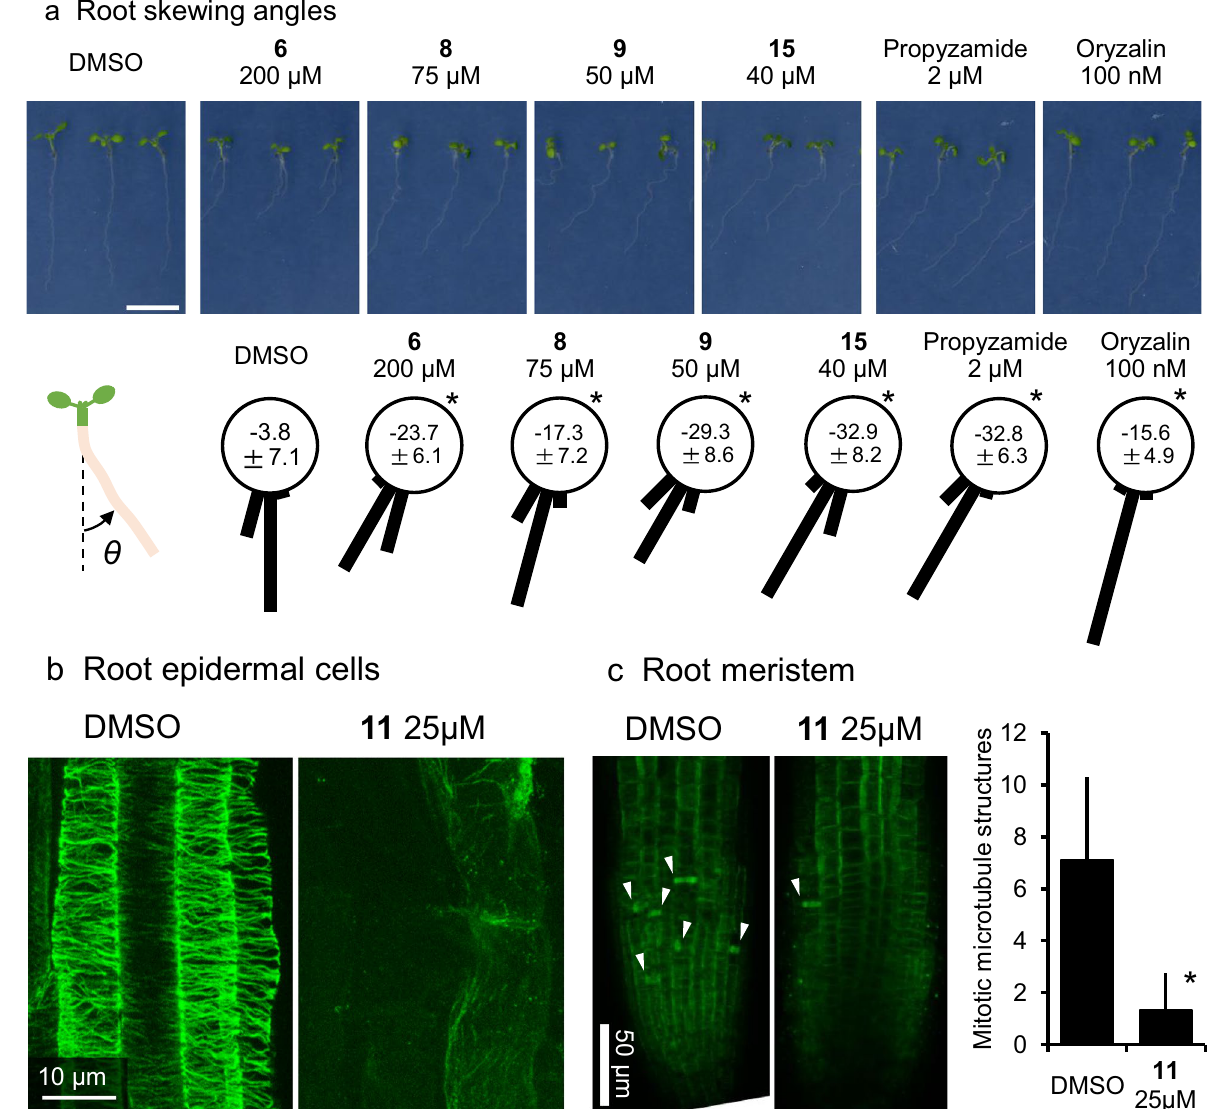
Figure 6. Kumamonamic acid and its derivatives altered cortical microtubules in Arabidopsis . ( a ) Root skewing angles measured in the presence of the indicated concentrations of different kumamonamic acid derivatives. The effects of two compounds, propyzamide and oryzalin, known to inhibit microtubules, were also analyzed. The illustration indicates the criteria used for the measurement of root growing angles. Asterisks indicate significant differences from mock treatment ( t -tests, p < .0.05). n > 19. Scale bar = 1 cm. ( b ) Cortical microtubules in epidermal cells of the elongation zone. Microtubules of wild-type Arabidopsis Col roots grown on MS plates with or without 25 μM KAND 11 were visualized by immunohistochemical staining using a β-tubulin primary antibody and an Alexa Fluor-conjugated secondary antibody. Scale bar = 10 μm. ( c ) Mitotic microtubule structures in the root meristem. Microtubules were visualized by immunohistochemical staining. Mitotic structures including preprophase bands, spindles and phragmoplasts in the confocal images were counted. Arrowheads indicate mitotic microtubule structures. Asterisks indicate significant differences from mock treatment ( t -tests, p < 0.05). n > 9. Scale bar = 50